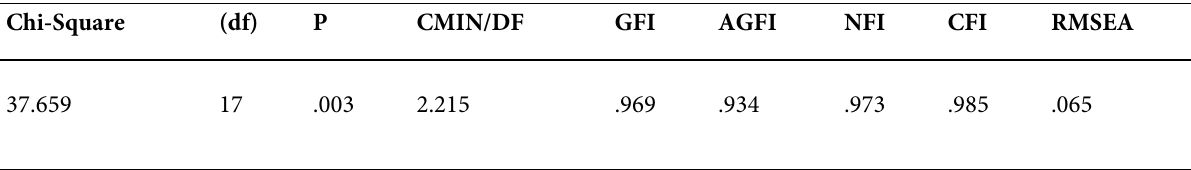
Table 3: Index of Fit of the Model